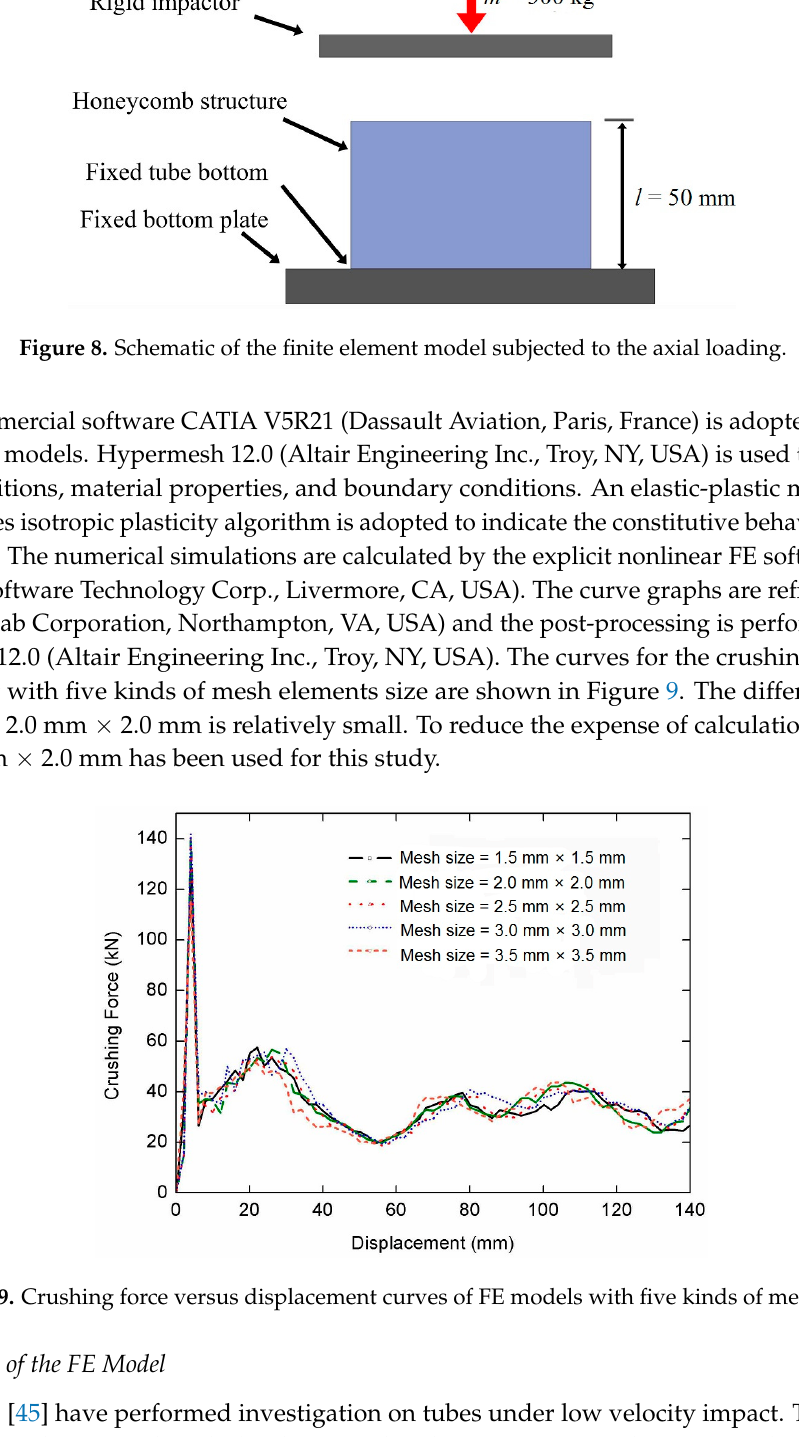
Figure 9. Crushing force versus displacement curves of FE models with five kinds of mesh sizes.